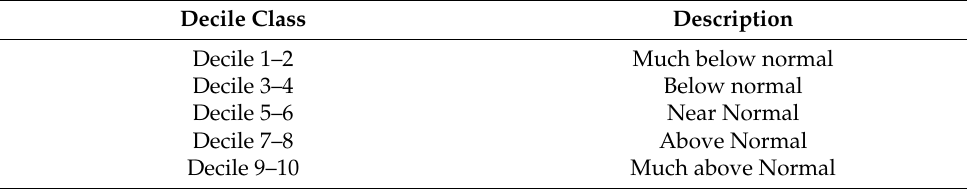
Table 3. Precipitation Decile